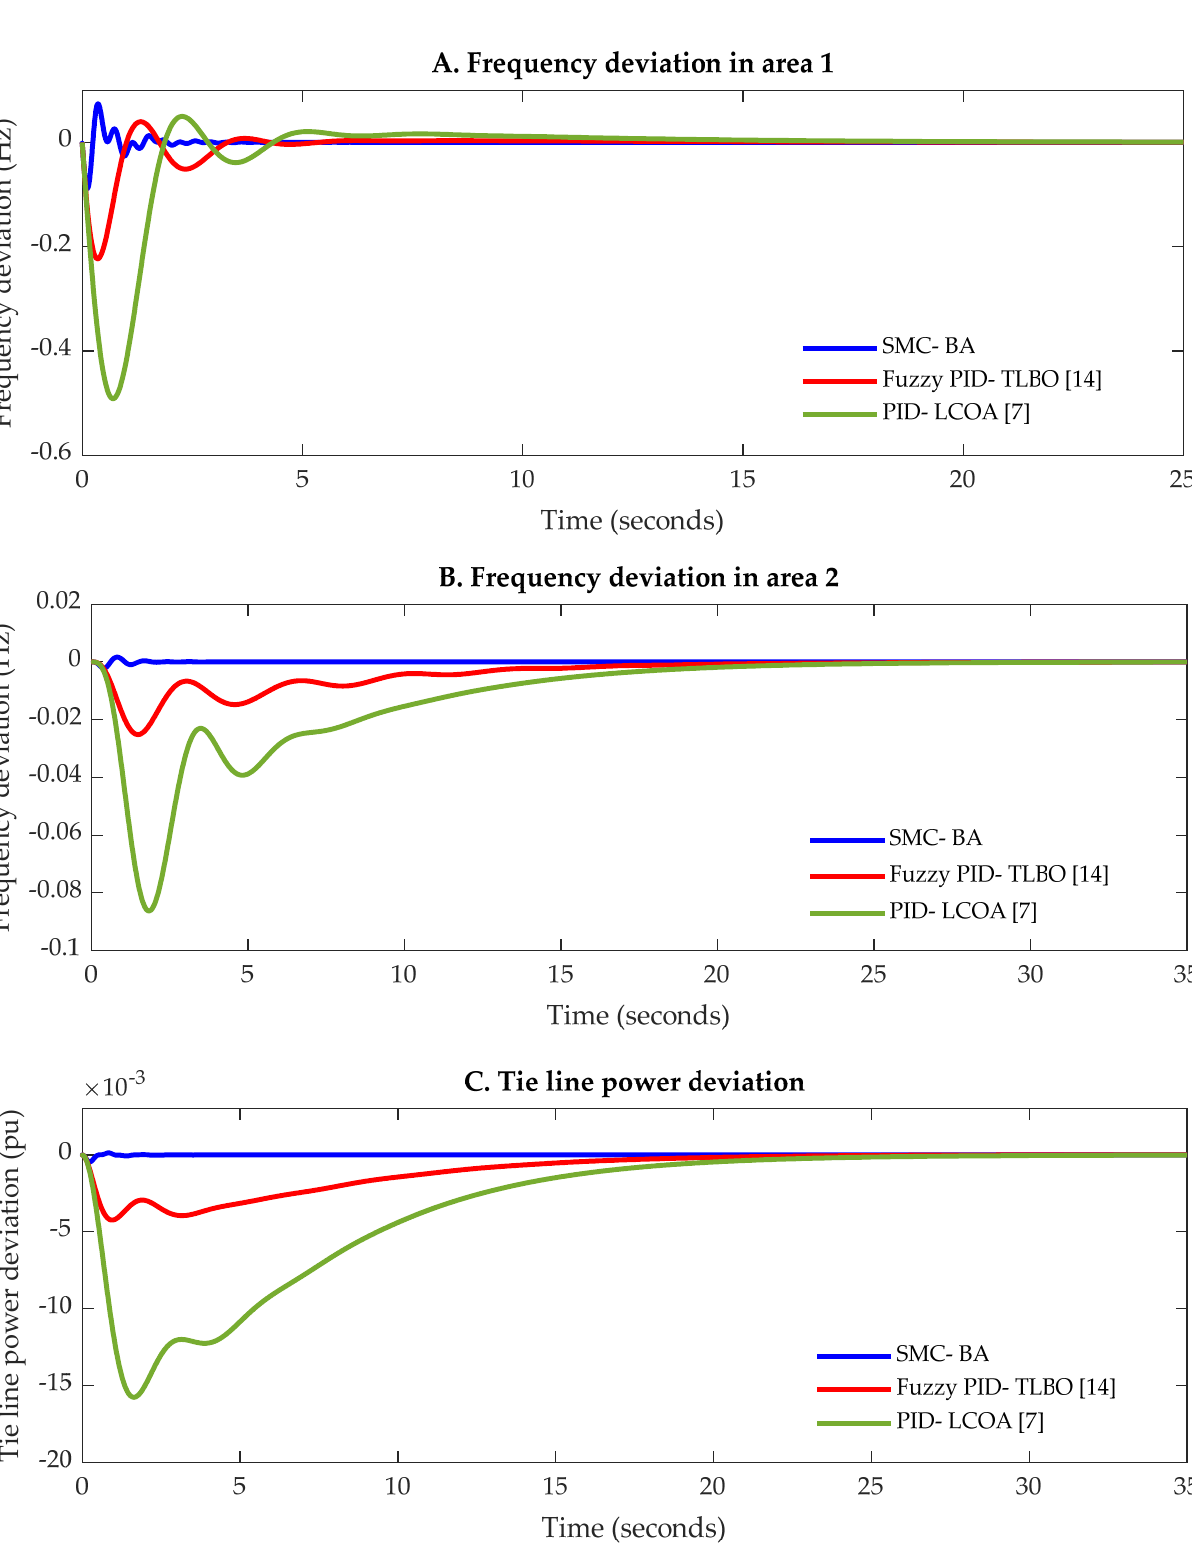
Figure 8. Dynamic response of the system with different controllers under parametric uncertainties, case 2. ( A ) Frequency deviation in area 1; ( B ) Frequency deviation in area 2; ( C ) Tie line power deviation.